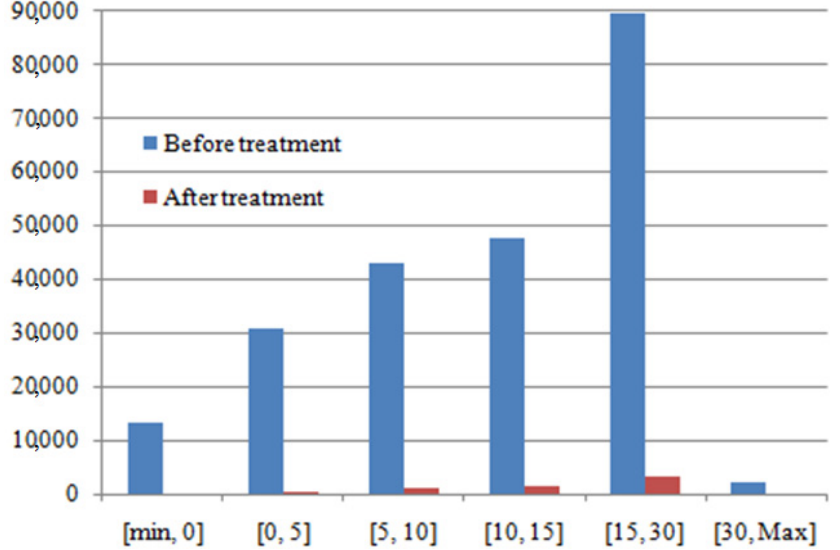
Figure 12. Histogram’s distribution of SINR (before and after treatment).